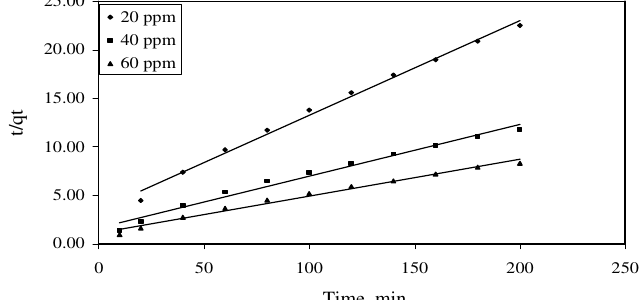
Figure 2c. Pseudo second order plot for Reactive Red 2 removal – initial dye concentration variation